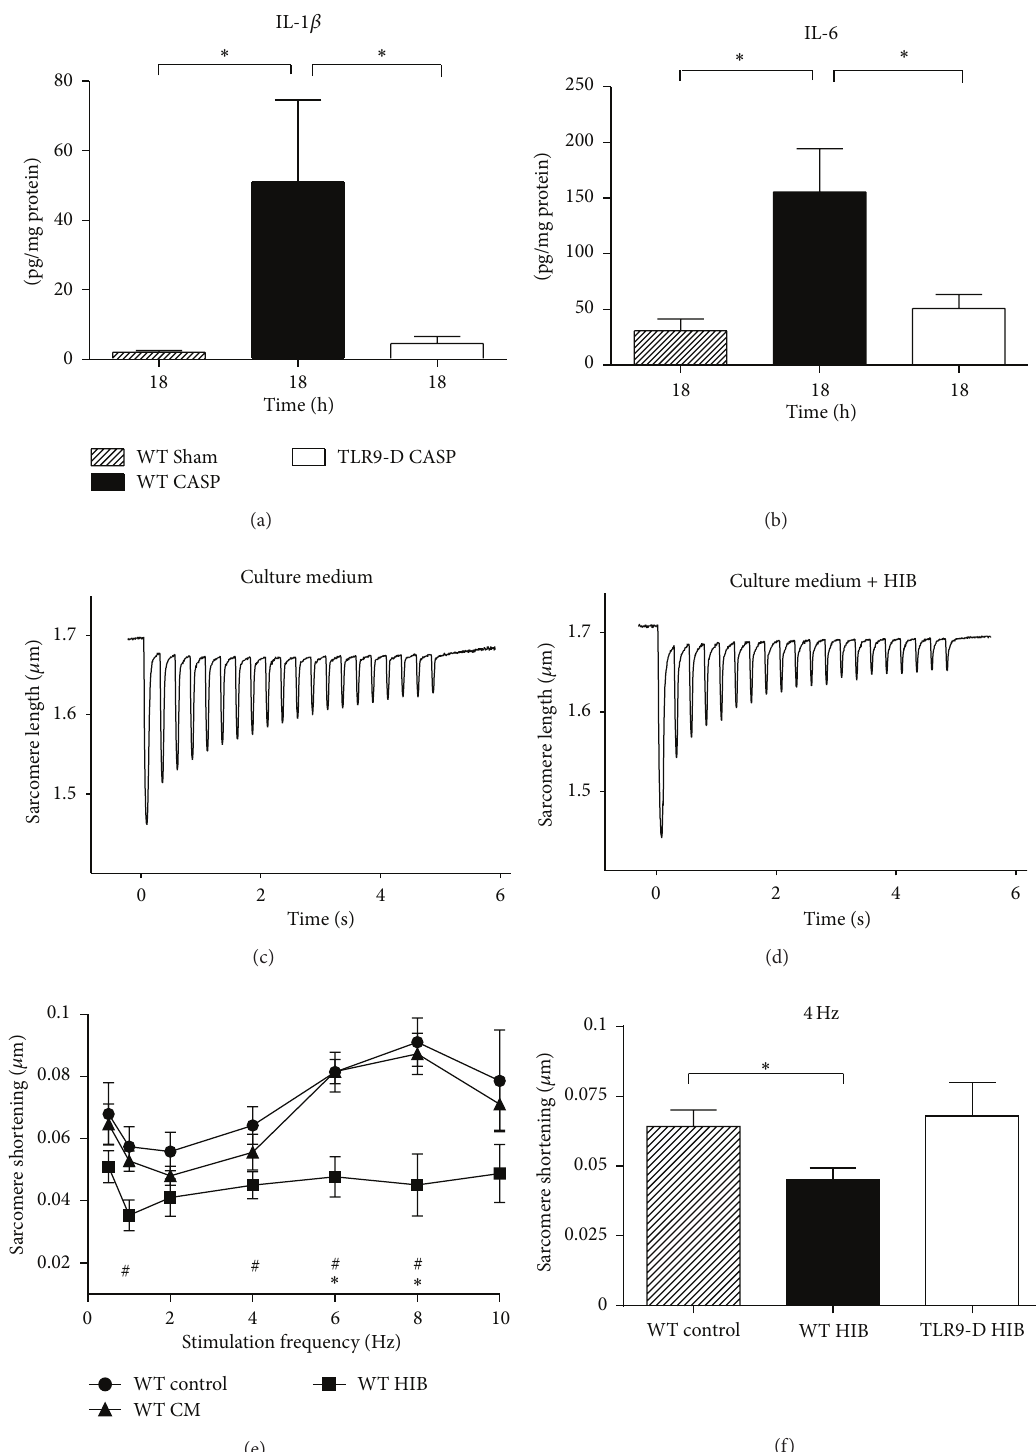
Figure 5: Protein levels of cytokines and cardiomyocyte contractility. (a), (b) Protein levels of proinflammatory cytokines were analysed via ELISA 18h after CASP in hearts of WT Sham, WT CASP, and TLR9-D CASP mice ( ∗ : 𝑃 < 0.05 ; 𝑛 = 8/ group; mean ± SEM). (c), (d) Original recordings of sarcomere shortenings of isolated cardiomyocytes incubated in culture medium (CM) or culture medium + heat- inactivated bacteria (HIB) stimulated at 4 Hz. (e) Plot of averaged sarcomere-shortening amplitude versus stimulation frequency recorded directly after isolation (WT control) or after incubation with culture medium (WT CM) or with CM + HIB ( # : 𝑃 < 0.05 WT HIB versus WT control; ∗ : 𝑃 < 0.05 WT HIB versus WT CM; 𝑛 = 6 – 12 /group; mean ± SEM). (f) Comparison of sarcomere-shortening amplitude at 4Hz stimulation frequency of WT control cardiomyocytes and WT and TLR9-D cardiomyocytes incubated in HIB for 5–7 h ( 𝑛 > 5 ; ∗ : 𝑃 < 0.05 ; mean ±